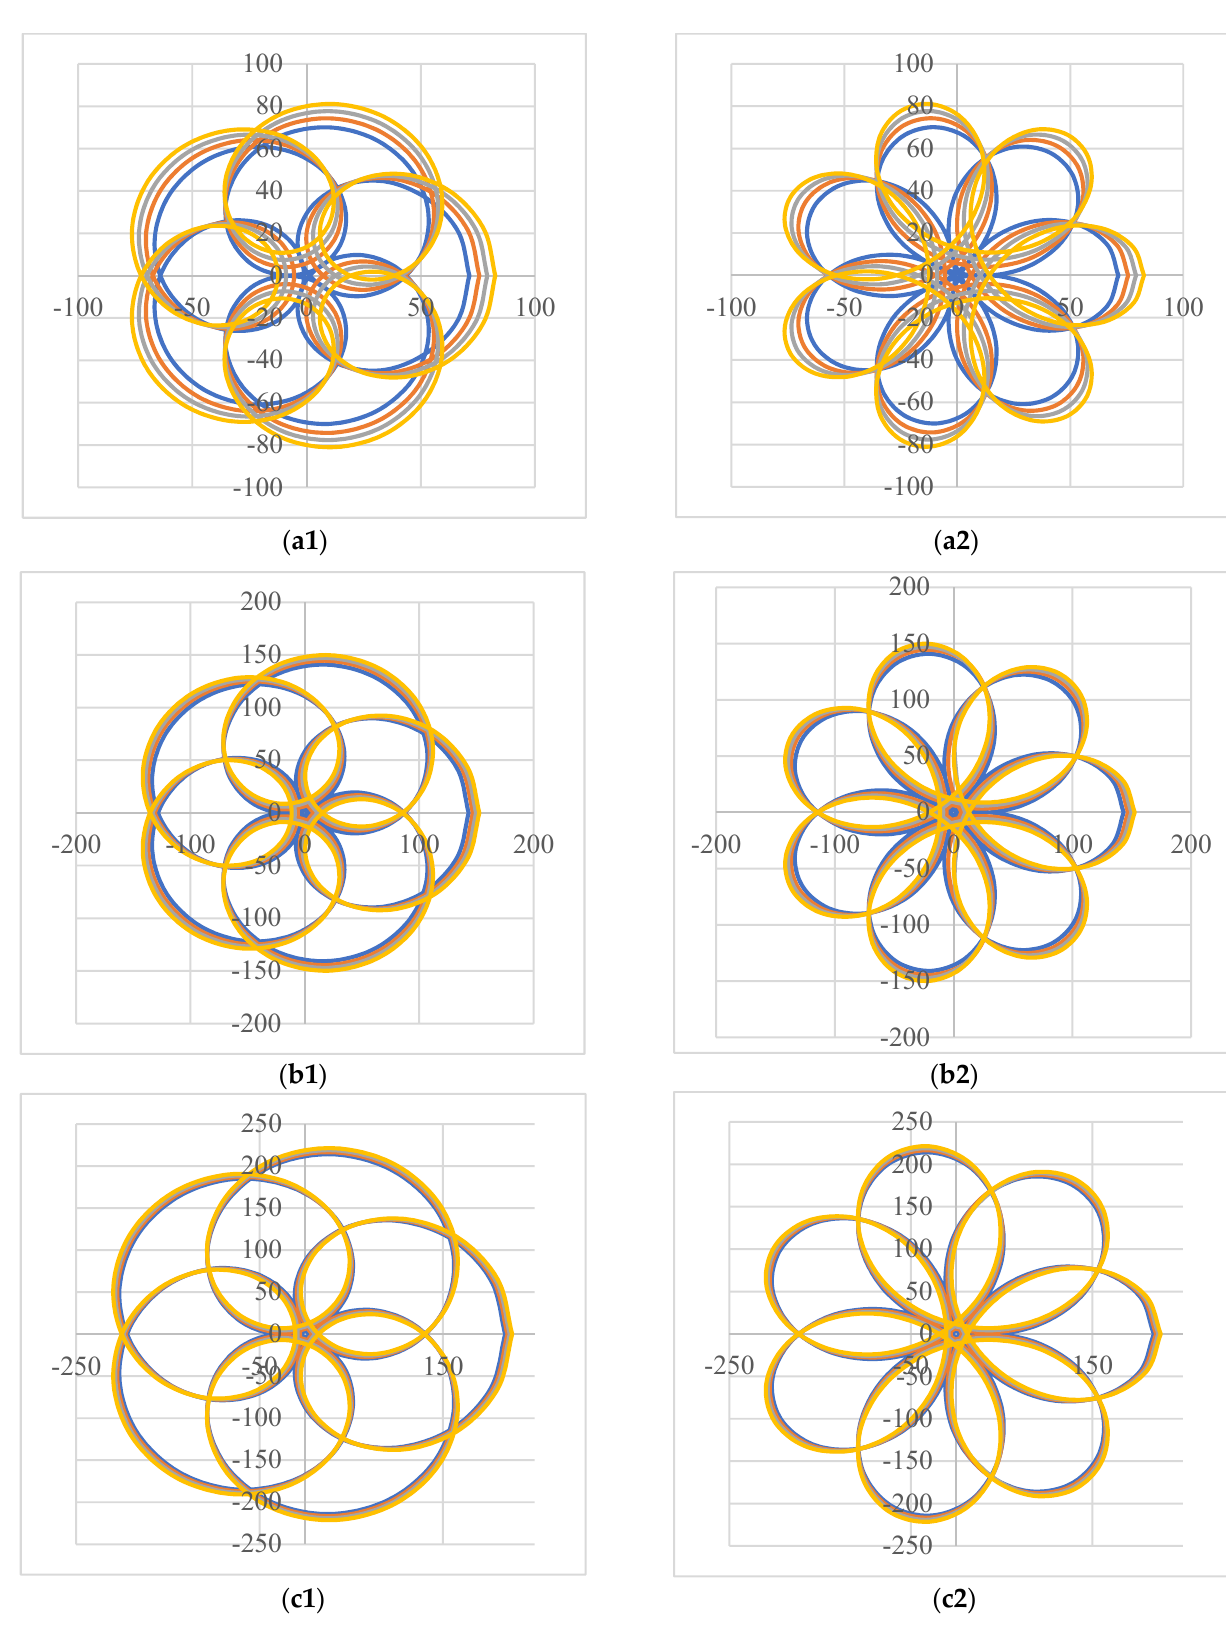
Figure 5. Study of the scan patterns produced by the configuration ba-ab of rotational Risley prisms (Figure 2d), for L = 1 m, e = 25 mm, and | M |= 6, with: ( a ) k = 1/2; ( b ) k = 2; ( c ) k = 3; ( d ) k = 5. ( 1 ) Left column, M > 0; ( 2 ) right column, M < 0 . The values on the axes are in millimeters.